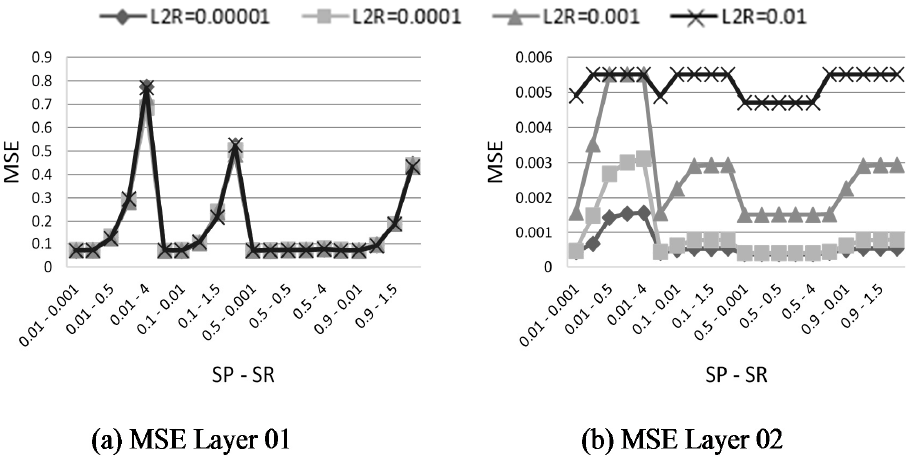
Figure 4. Parameter selection for both layers. As a greedy layer-wise training strategy was adopted, layer two was trained independent of layer one. The same parameter values were varied for both layers and the best values were chosen to optimise the errors at ( a ) layer one and ( b ) two. Both the AEs were trained with the scale conjugate gradient descent function [67] using greedy layer-wise training [68]. Finally, the softmax layer was trained in a supervised fashion, then stacked